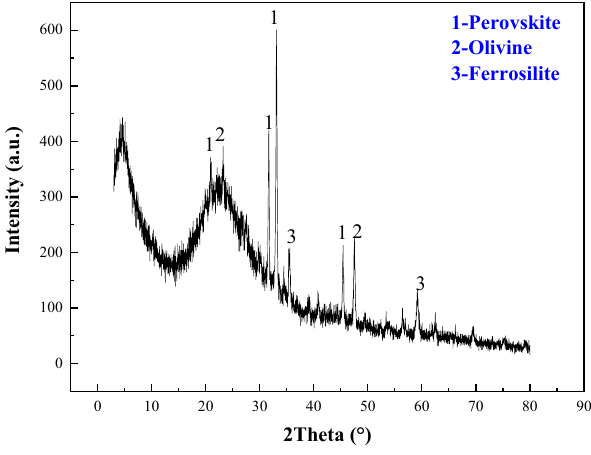
Figure 9. X-ray diffraction (XRD) diffractogram of hydrochloric acid leaching residue.